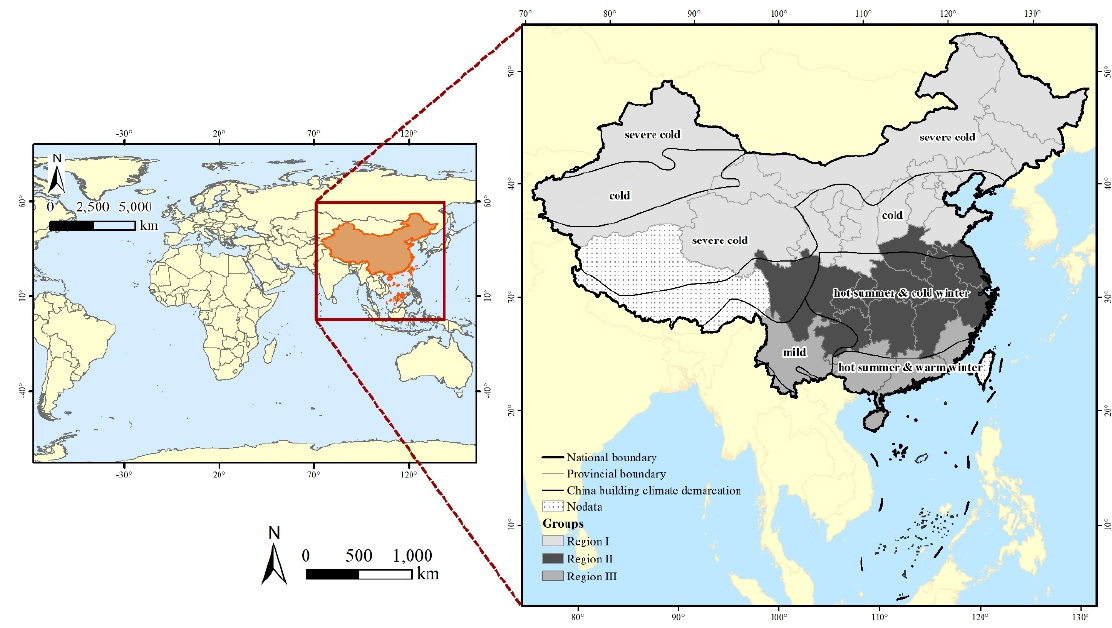
Figure 2. Provincial grouping based on China’s building climate demarcation.